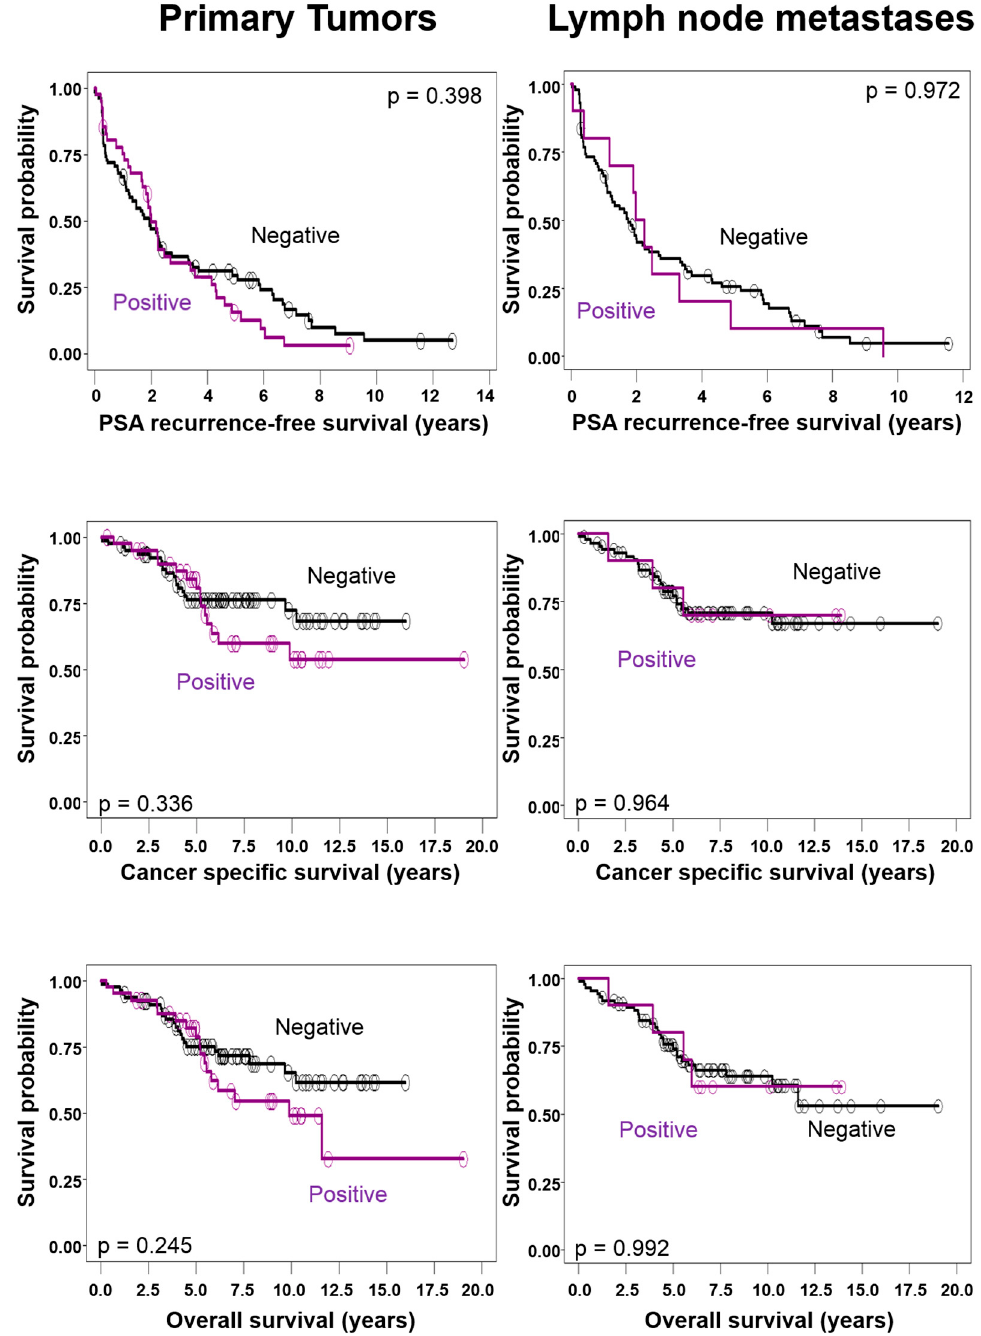
Figure 2. Chromogranin A expression in primary tumors and metastases is not significantly correlated with outcome.